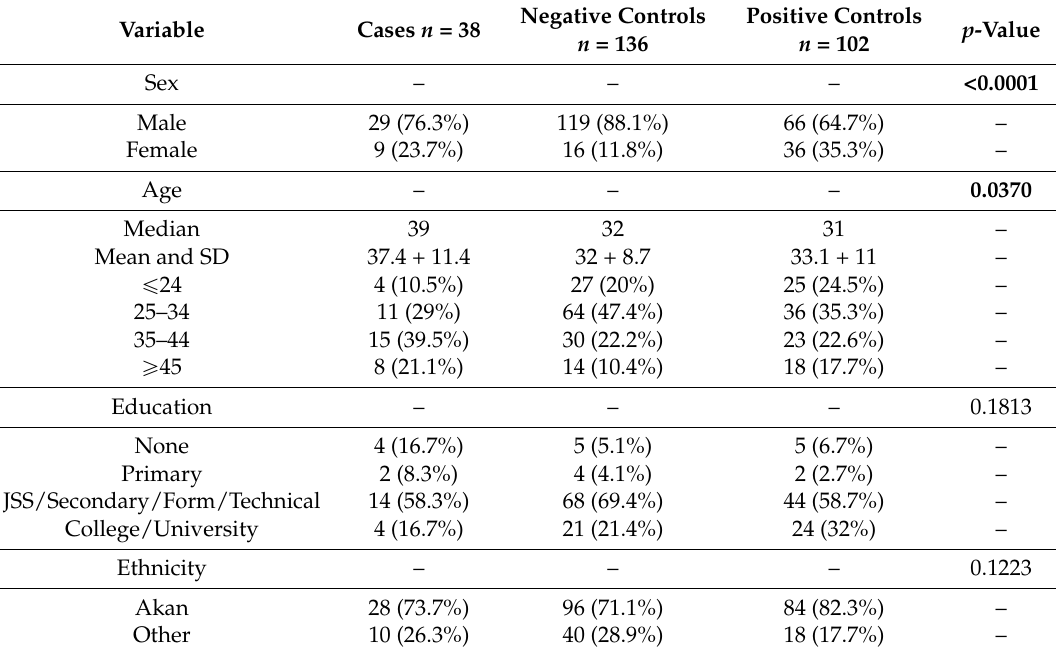
Table 1. Sociodemographic characteristics of study